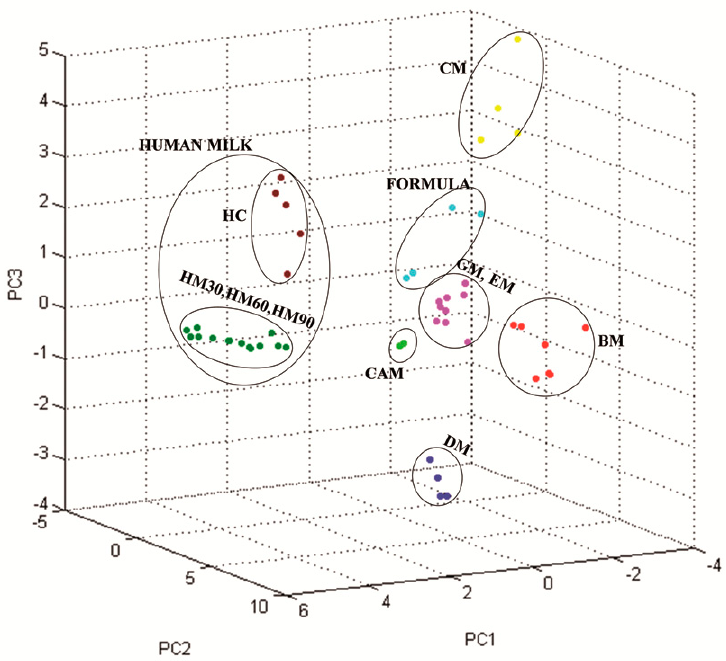
Figure 6. 3D scatter plot image from the principal component analysis (PCA) for human milk at 2, 30, 60, and 90 days (HC, HM30, HM60, and HM90, respectively), infant formula milk (A, F, H, and N), and animal milk (CM, BM, GM, EM, DM and CAM). Each spot represents one milk sample.